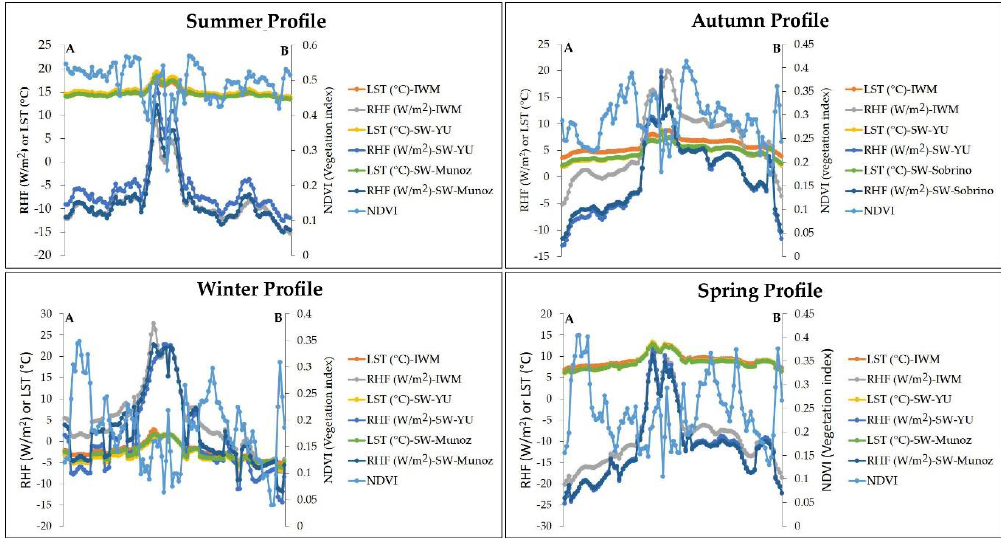
Figure 24. Variation in land surface temperature (LST) and radiative heat flux (RHF) as a function of the normalised difference vegetation index (NDVI) along profile A–B, shown in Figure 1. The LSTs and RHFs were calculated using all three of the following methods: IMW—improved mono-window algorithm; SW-Yu—split-window algorithm of Yu et al. [19]; and SW-Muñoz—split-window algorithm of Jiménez-Muñoz et al. [20]. The panels show the variation in each season.